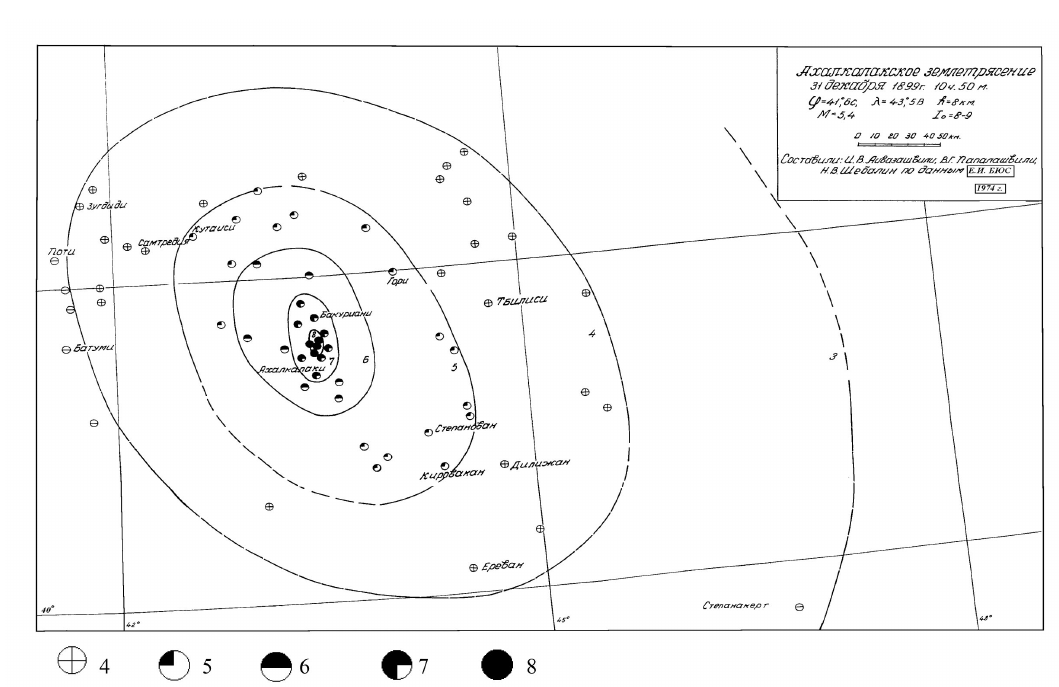
Fig. 5. Isoseismal map of 31 December 1899, Akhalkalak earthquake from unpublished Atlas prepared in 1974 as supporting dataset for Kondorskaya and Shebalin (1982). According to the legend it is based on data from Bius